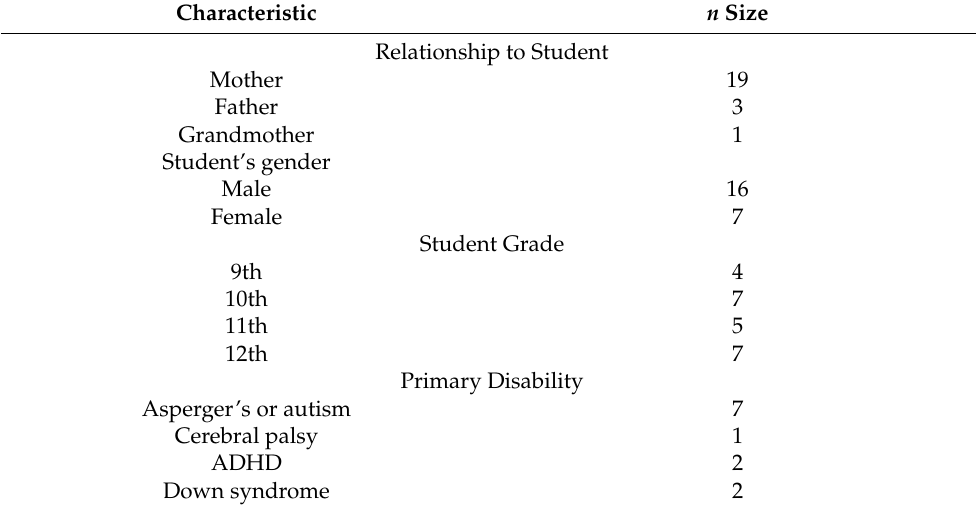
Table 1. Family and Student